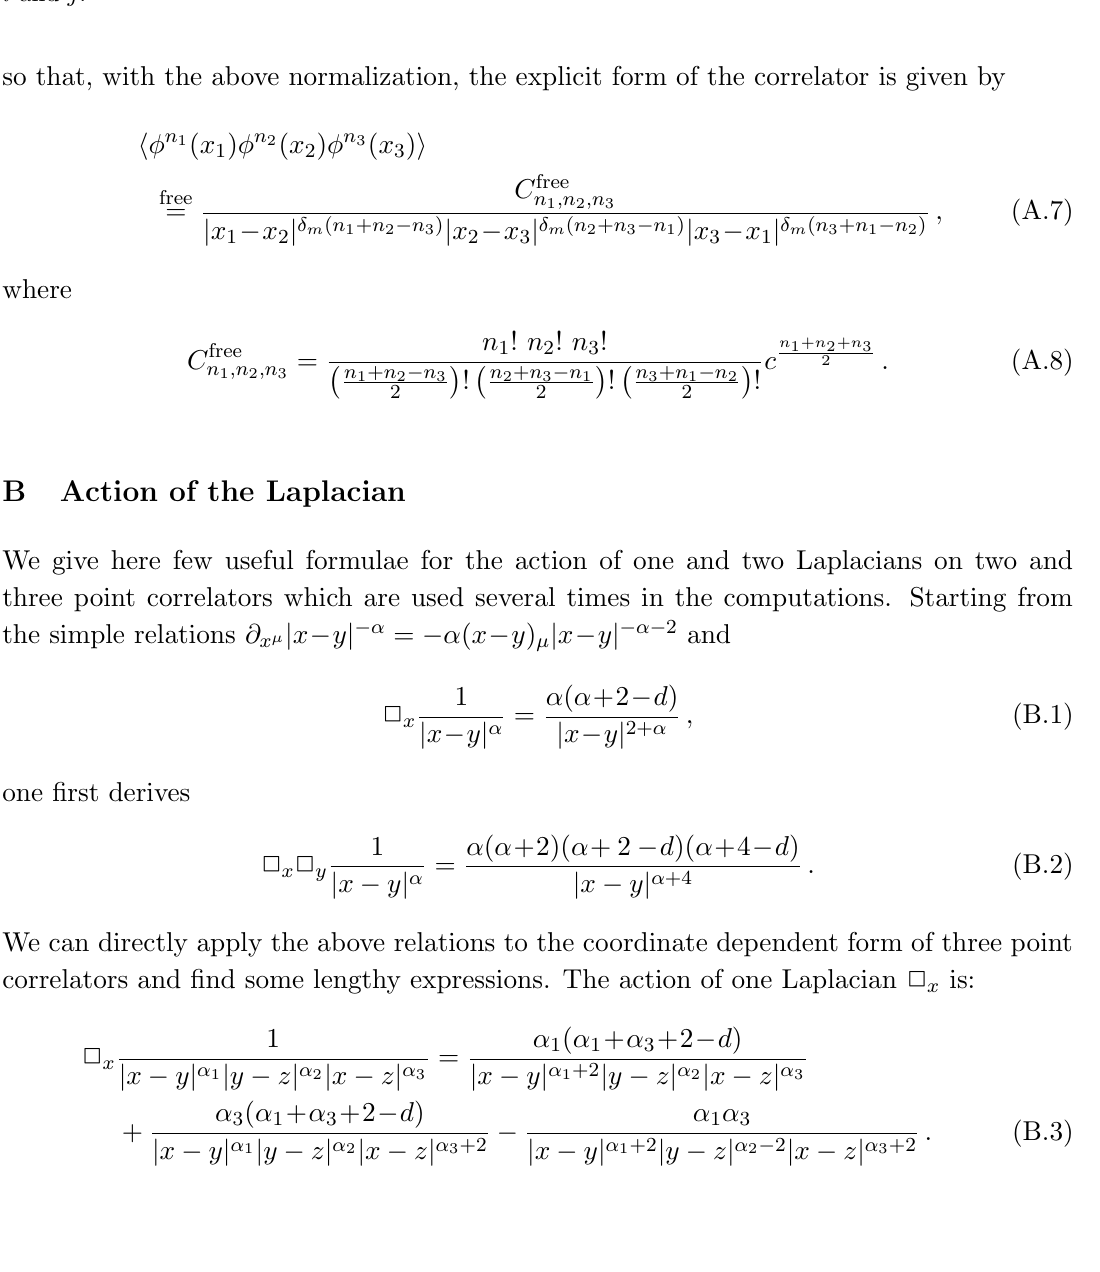
Figure 1 . Wick contraction counting of a three point correlator. The vertices are labelled by i = 1 ; 2 ; 3, the order of the i -th vertex is n i , and there are l ij lines connecting two distinct vertices i and j